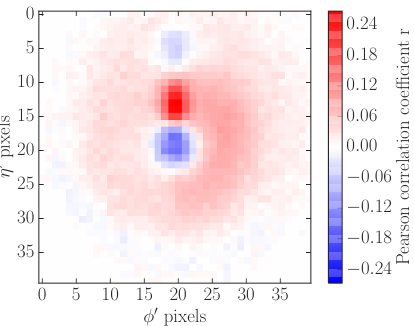
Figure 7 . Pearson correlation coe(cid:14)cient for 10,000 signal and background images each. The corresponding jet image is illustrated in (cid:12)gure 1. Red areas indicate signal-like regions, blue areas indicate background-like